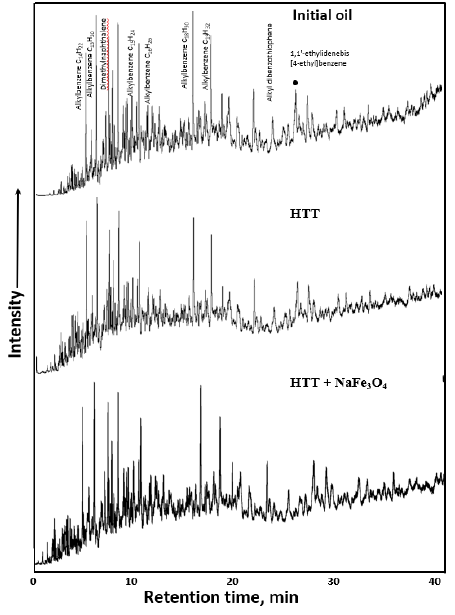
Figure 12. GC-MS of aromatics.